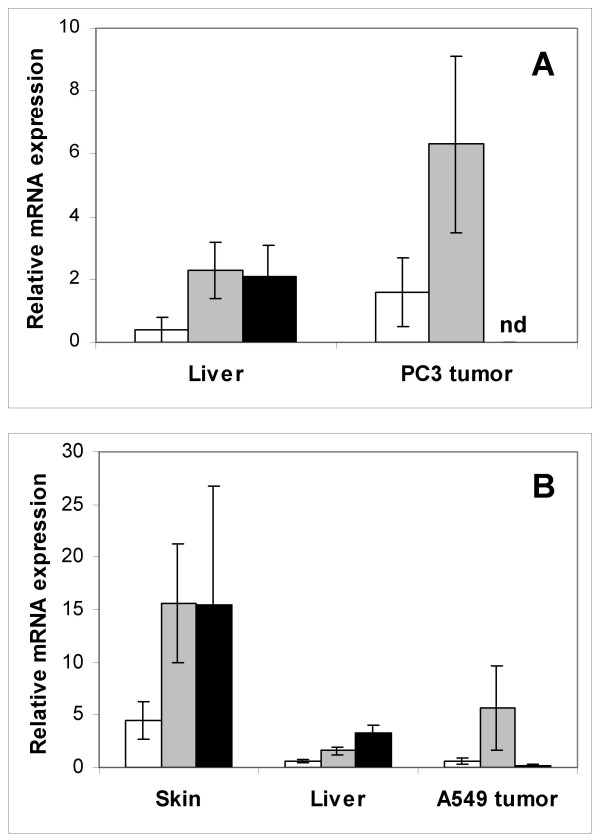
HIP mRNA expression in normal mouse tissues vs. PC3 and A549 tumors. 100 ng of RNA extracted from A, normal livers or PC3 human prostate xenograft tumors from nude mice, or B, normal livers, normal skin, or A549 tumors from nude mice, were assayed for vWF, CD146, and HIP mRNA expression by Q-RT-PCR. The vWF (white bars), CD146 (gray bars), and HIP (black bars) mRNA levels were normalized to the GAPDH mRNA level in each RNA sample and are presented as the mean with standard deviation (A, N = 3 for normal liver, N = 8 for PC3 tumor; B, N = 5 for normal liver, N = 5 for normal skin, N = 3 for A549 tumor). nd = not detectable (no signal from Q-RT-PCR assay after 40 cycles).